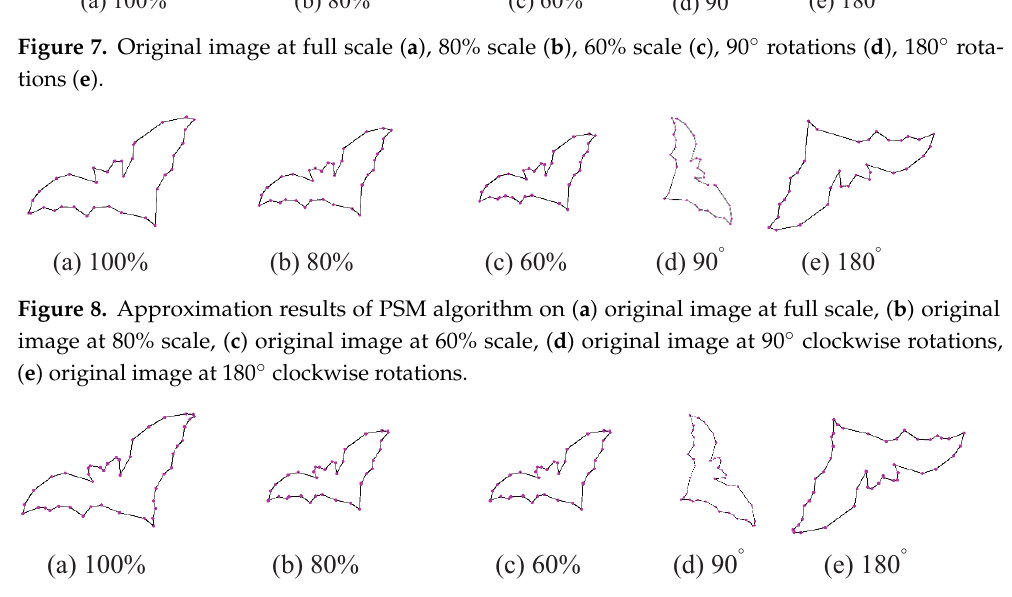
Figure 9. Approximation results of SM algorithm on ( a ) original image at full scale, ( b ) original image at 80% scale, ( c ) original image at 60% scale, ( d ) original image at 90 ◦ clockwise rotations, ( e ) original image at 180 ◦ clockwise rotations. Table 1. Comparison of the number of polygon vertices.